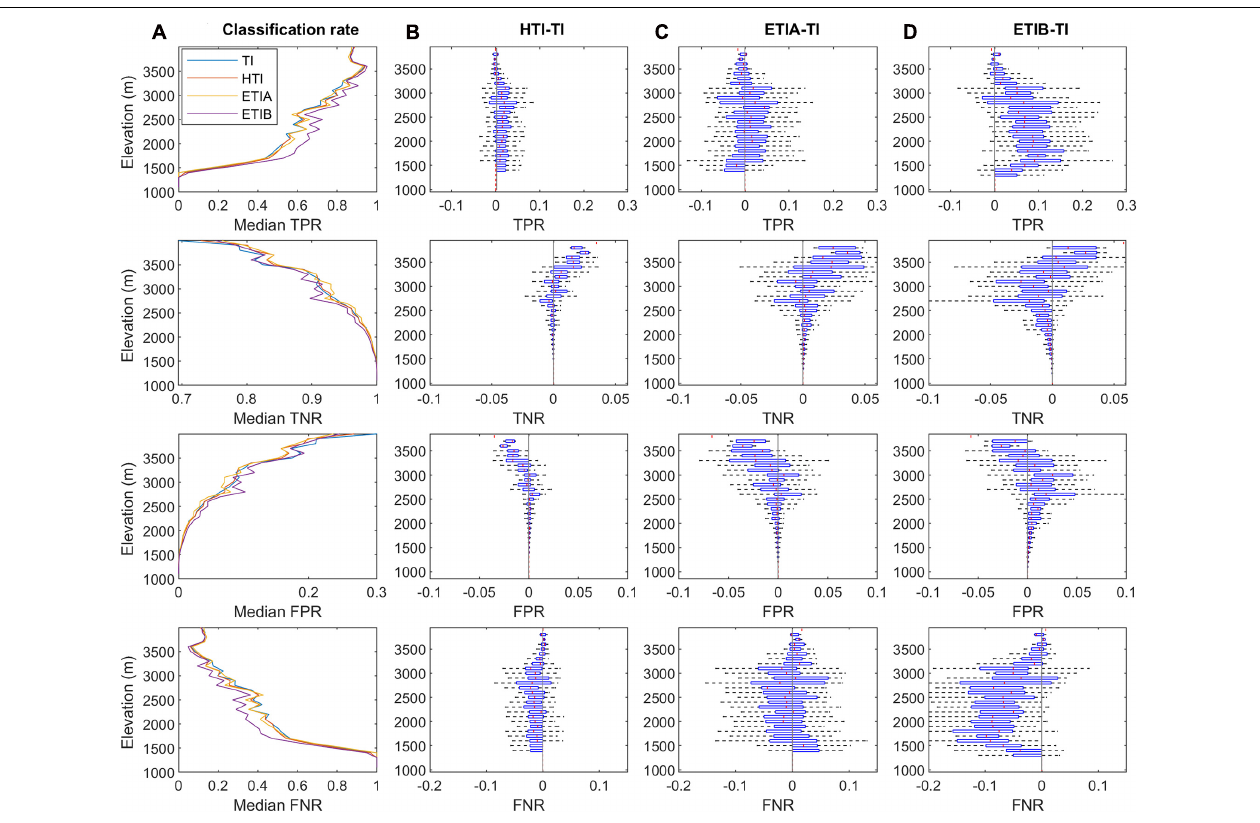
FIGURE 8 | SCA classification errors by elevation; 1st row, true positive rate (TPR); 2nd row, true negative rate (TNR); 3rd row, false positive rate (FPR); 4th row, false negative rate. (A) Median error rate. (B–D) Differences between radiative and classical TI